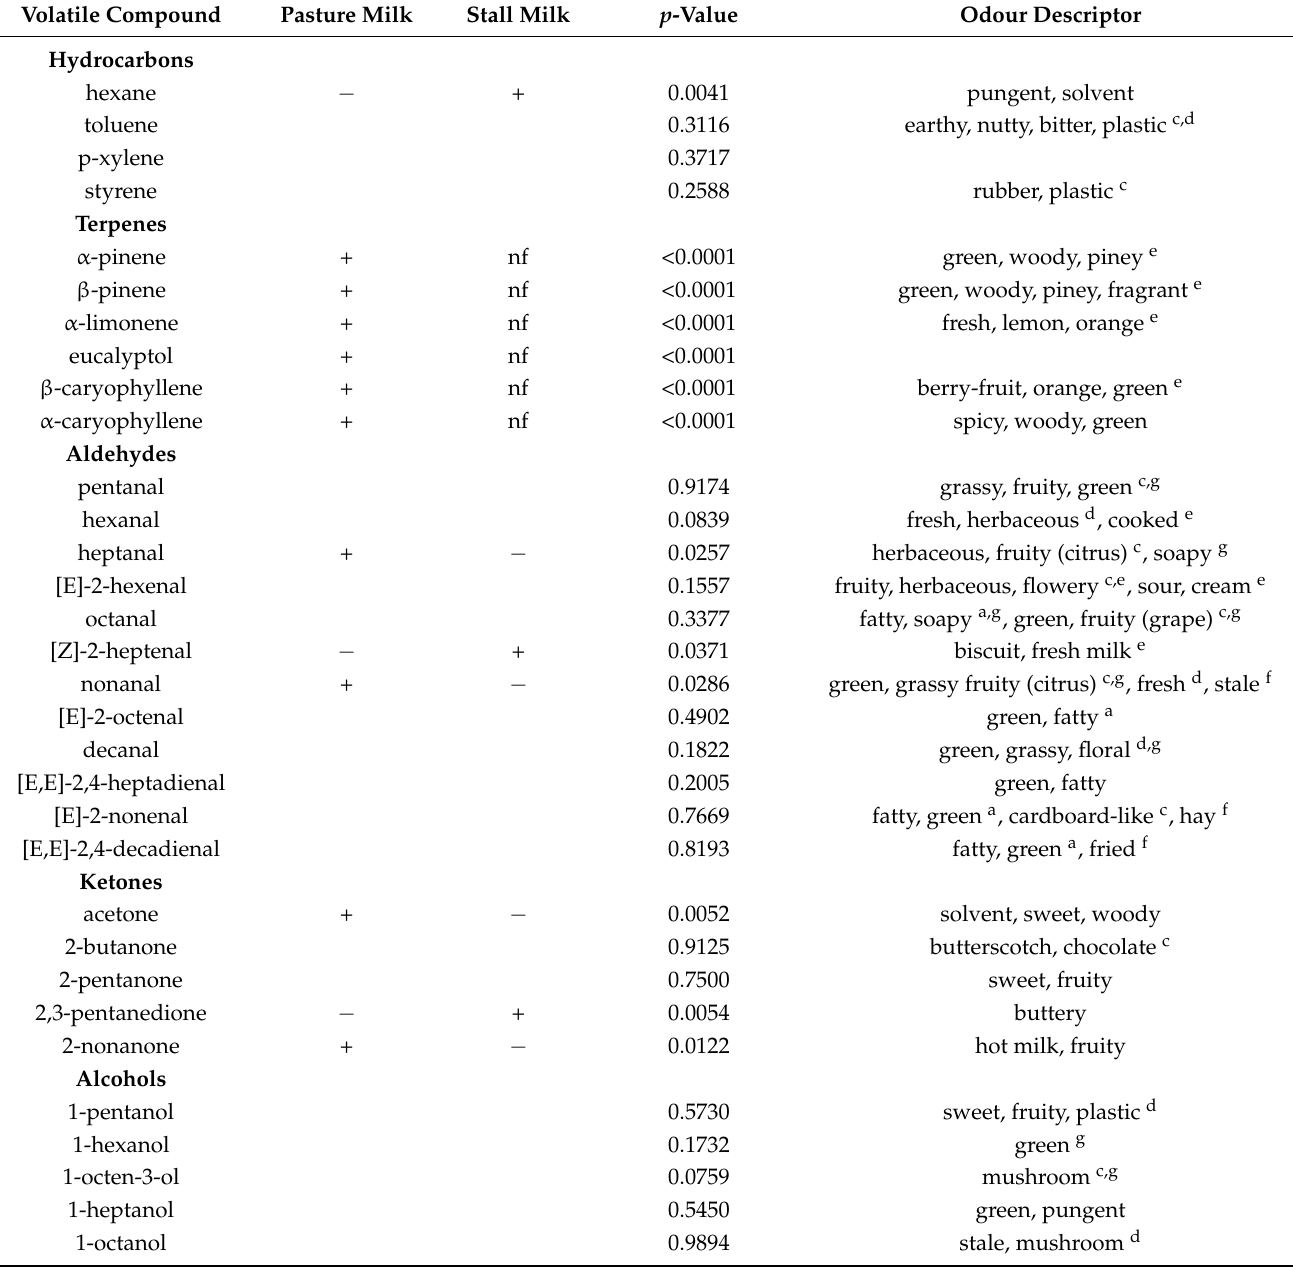
Table 4. Quantitative data of volatile organic compounds identified in bulk milk samples obtained from goats fed on a pasture (P) or stall (S)-based